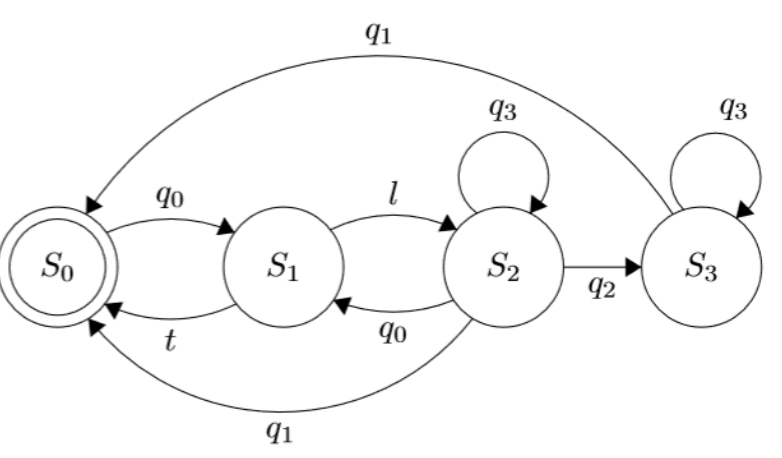
Figure 8. Comportment of the UPI from the version based on object recognition. S 0 indicates that the prosthesis it is completely open; S 1 , that a picture is being taken; S 2 , that a label is being determined (when this process is finished, the flag l is lifted, if not, timeout t is raised); and S 3 , that the action is being executed.